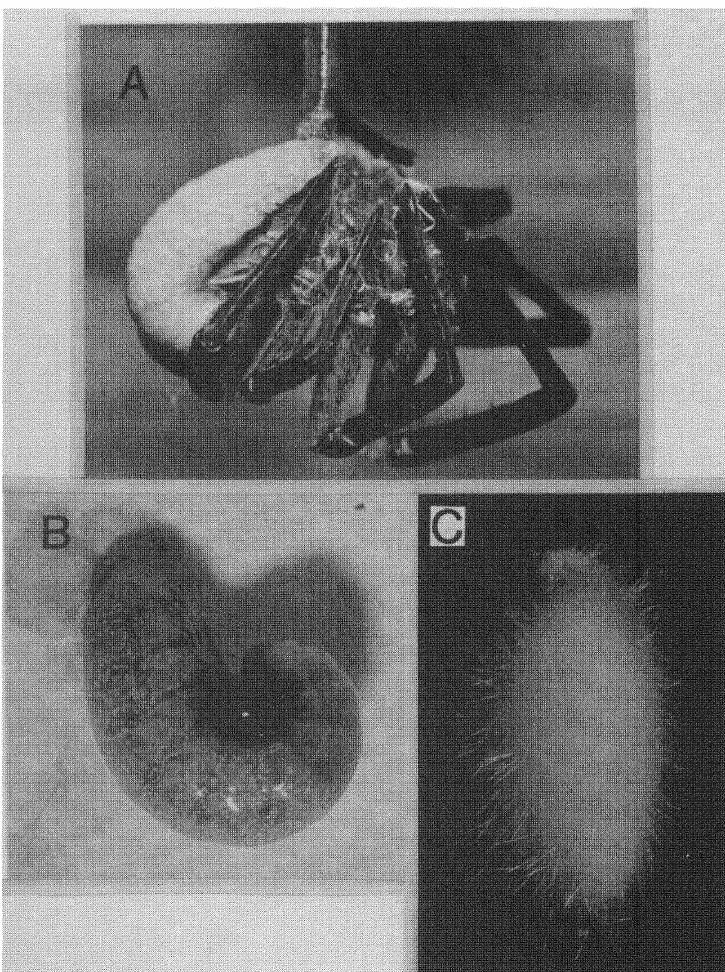
Fig. 5. Larva of A. azureus at 5 days (A) and 8 days (B); C, cocoon of A.